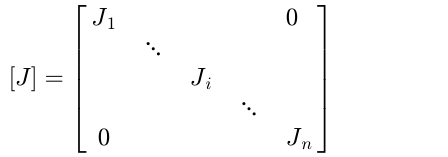
Fig. 8. Two-dimensional fi nite element mesh of the